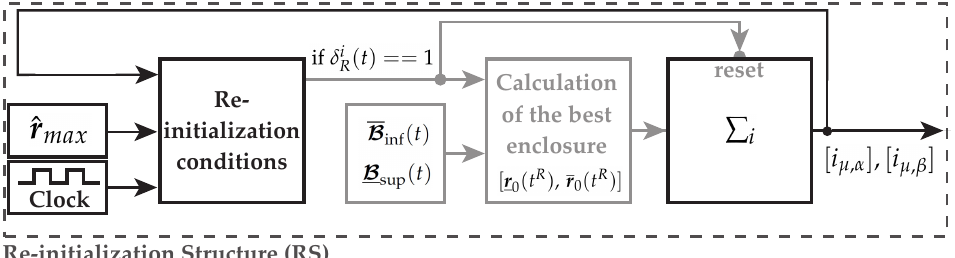
Figure 4. Structure and signal flow of the re-initialization process of one reduced-order hybrid interval observer. The gray part of the algorithm is executed only if the condition δ i is